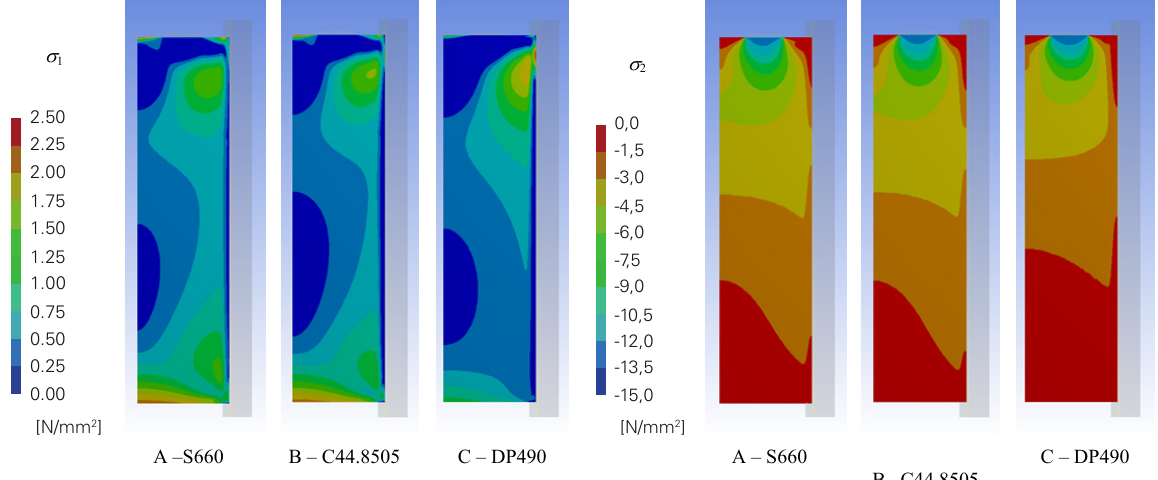
Fig. 9 Priniciple stress  2 (compression) in the glass pane (right half), specimen loaded by 20 kN